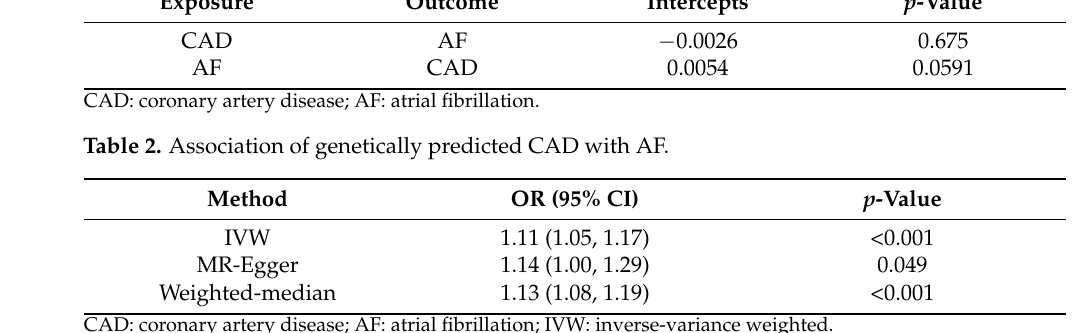
Table 1. Intercepts of Mendelian randomization (MR)-Egger regression analysis. Exposure